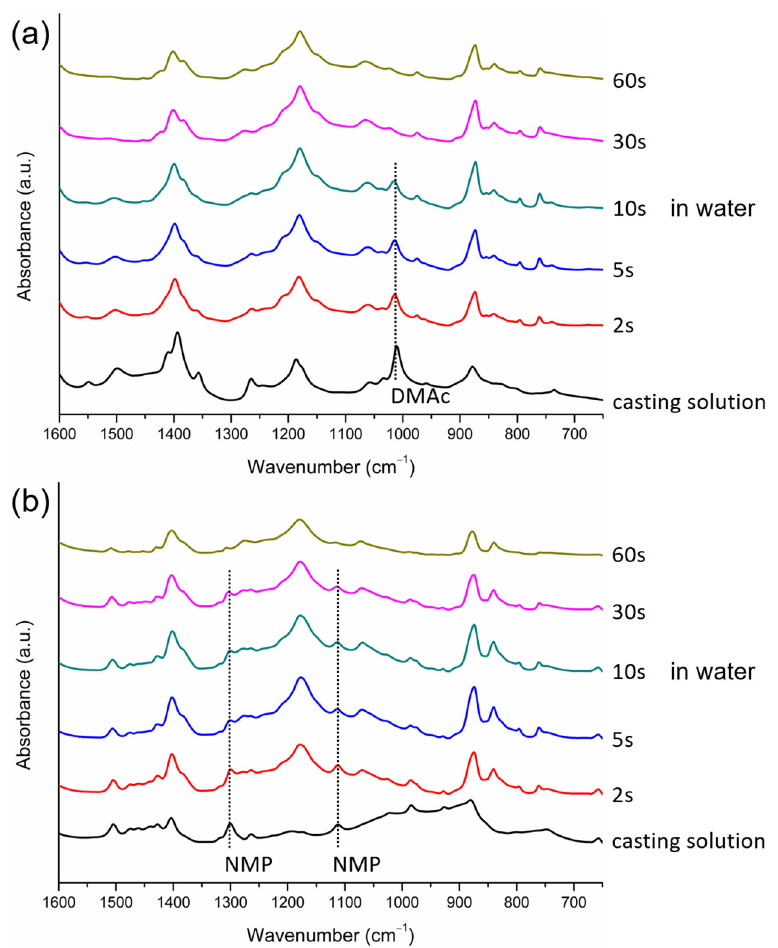
Figure 9. FTIR/ATR spectra of the surfaces of PVDF cast films at different times after immersion in water, with DMAc ( a ) or NMP ( b ) as the solvent.